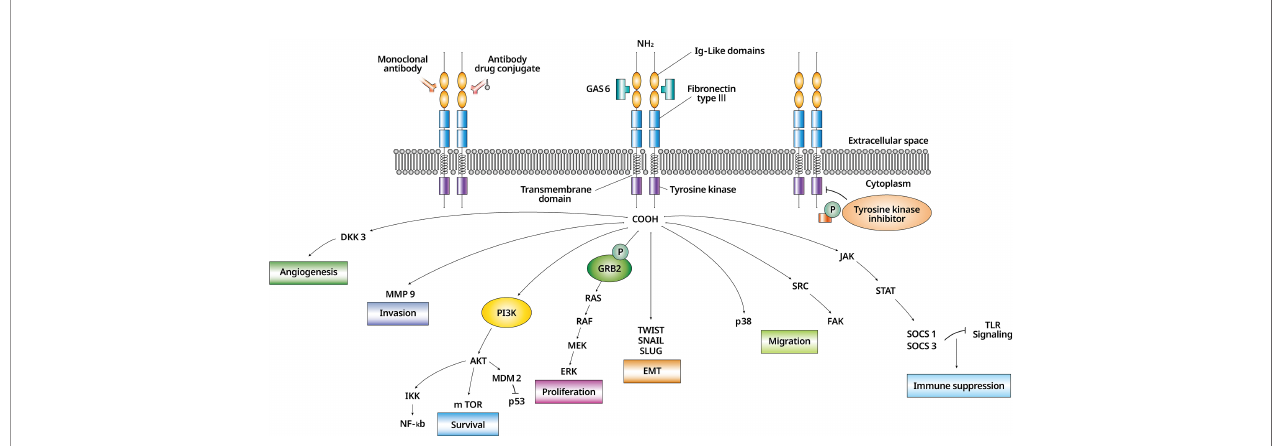
FIGURE 1 | The biology of AXL/Gas6 signaling activation and downstream effectors in malignant cell. AXL/Gas6 activation and downstream signaling is shown. AXL promotes cell survival, proliferation, invasion, migration, angiogenesis, EMT, and immune suppression. An AXL inhibitor is expressed as a monoclonal antibody, an antibody-drug conjugate, and a tyrosine kinase inhibitor according to three different mechanisms. EMT, epithelial to mesenchymal transition; Gas6, growth arrest-speci fi c